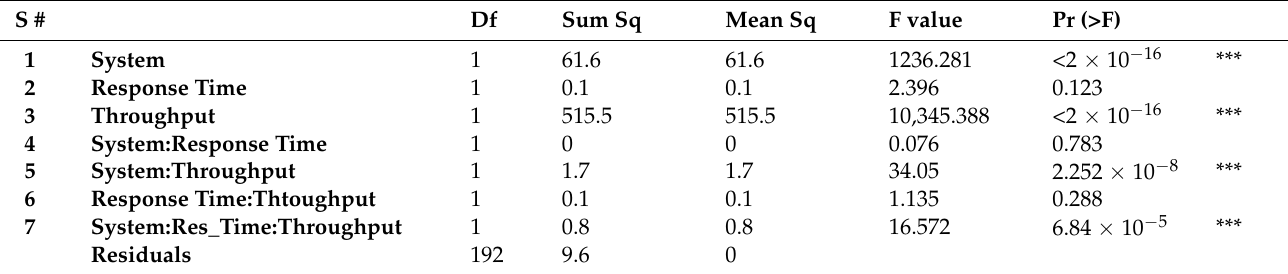
Table 6. Result of Statistical Analysis of